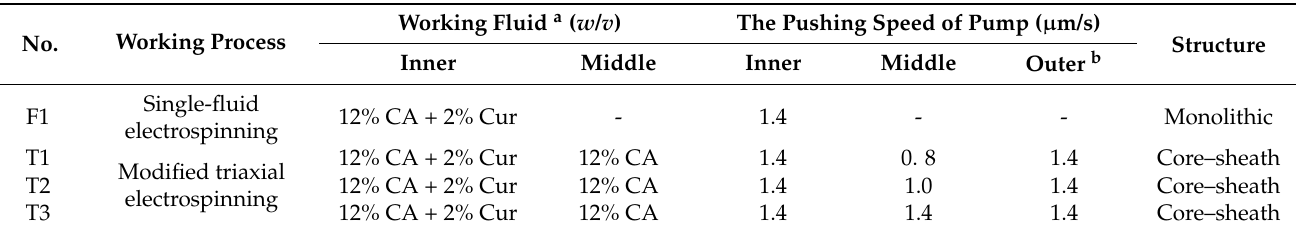
Table 1. Parameters of the four drug-loading electrospun